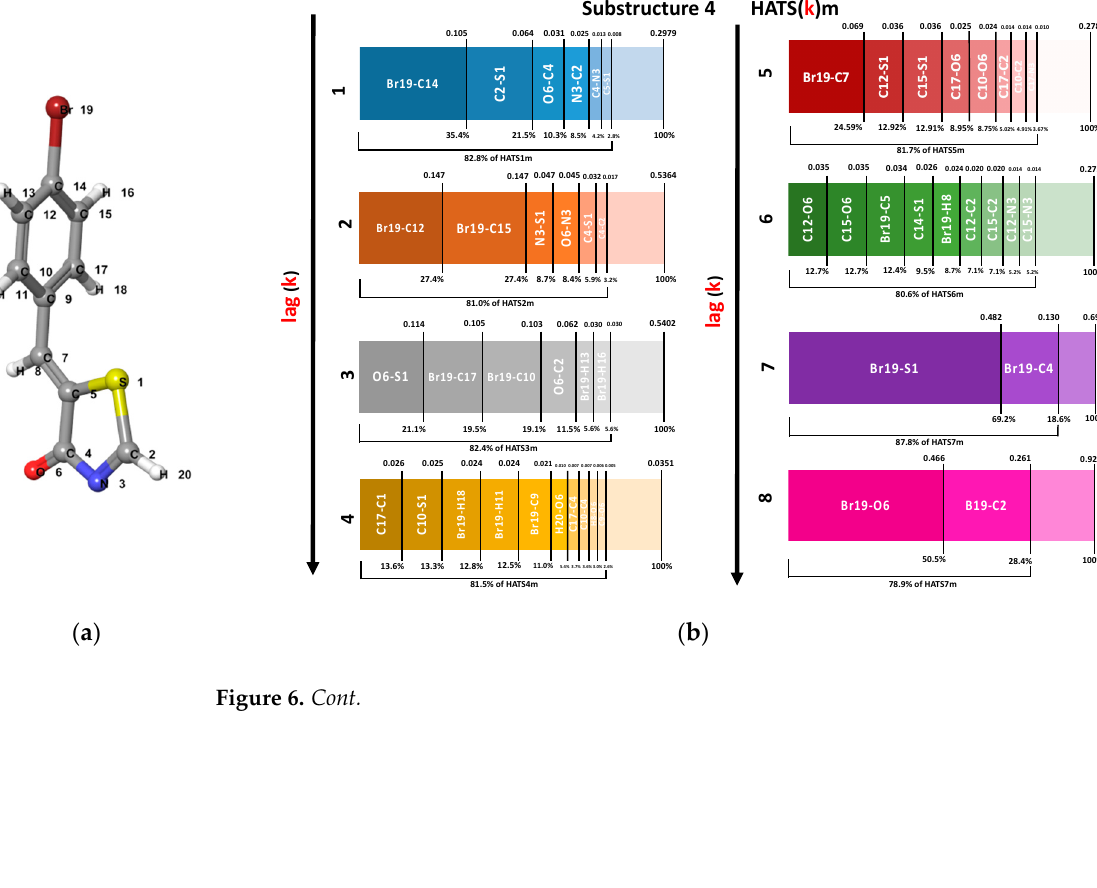
Figure 5. The cutting of the compounds Les1, Les2, Les3, and Les-4 leads to substructures 1, 2, 3, and 4, respectively. Common core is highlighted in red, and substituent R4 is blue.